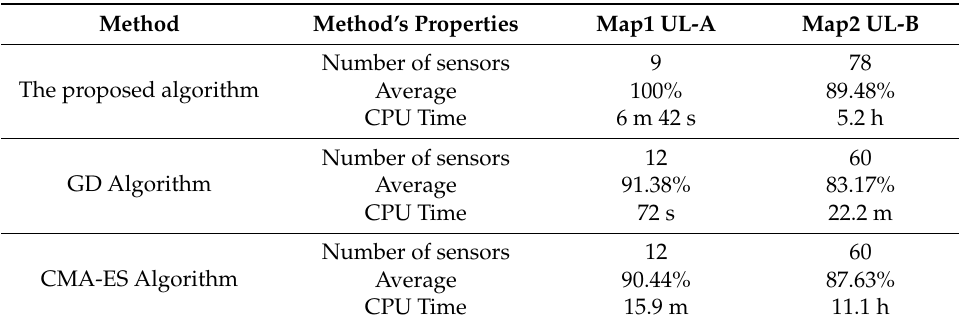
Table 2. Coverage percentage, number of sensors, and processing time of the different methods. (Time is reported in seconds (s), minutes (m), and hours (h)).